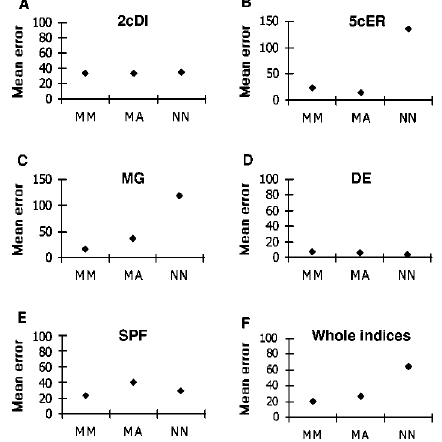
Fig. 3. Mean errors for three automatic methods on each DNA indice evaluation for the three tumours: 2cDI (A), 5cER (B), MG (C), DE (D), SPF (E). Mean error occurring on the five indices taken as a whole for the three tumours is also represented